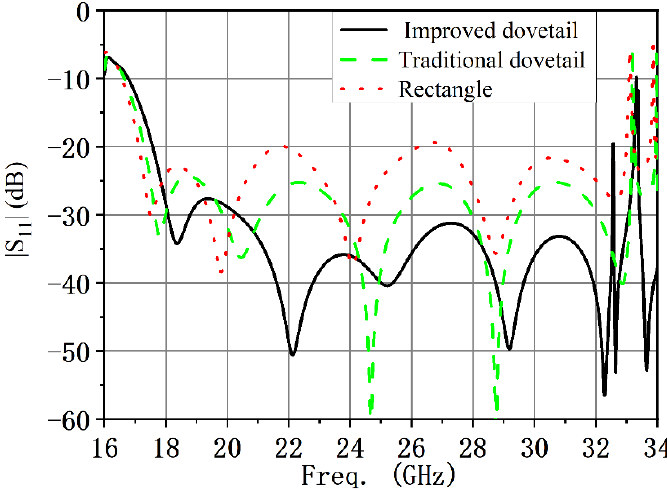
Figure 4. Simulated |S 11 | of three different shapes of dielectric plates.